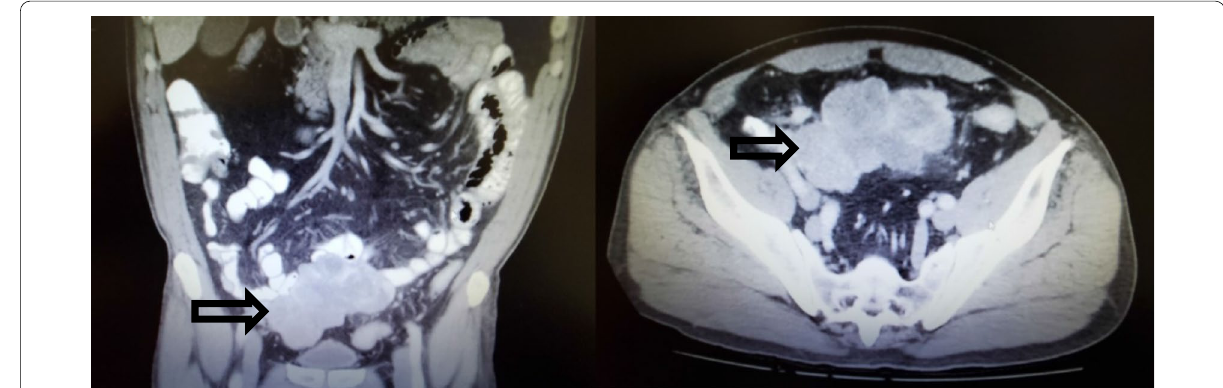
Fig. 1 Heterogeneous SFT mass in the midline of the pelvis measuring 11.4